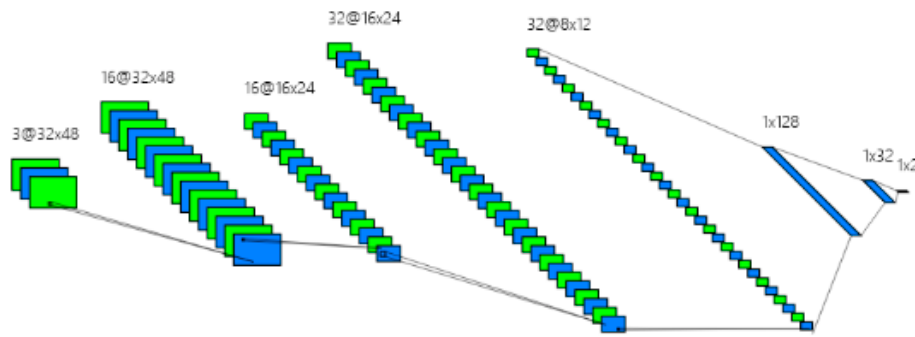
Figure 7. The network architecture of CNN classification model.